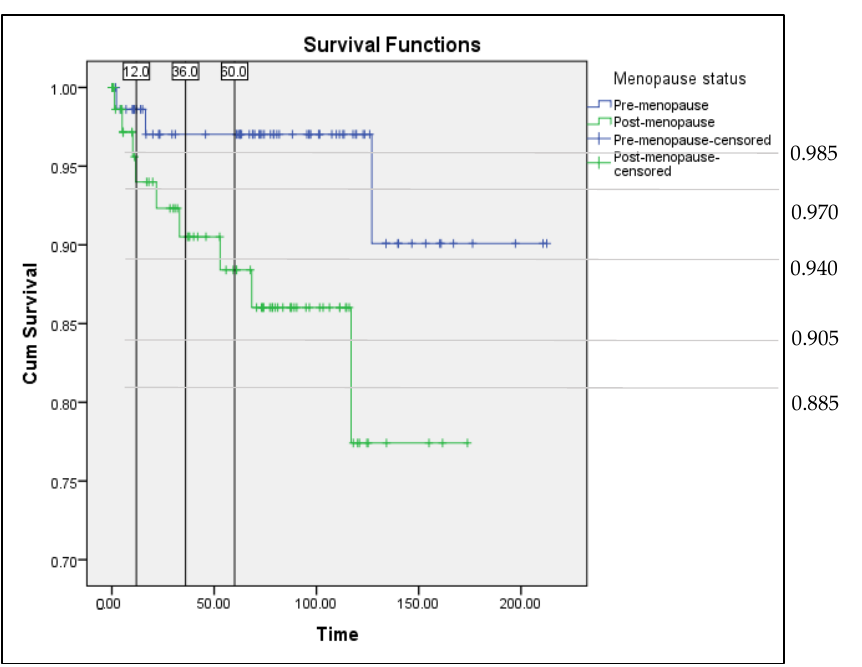
Figure 2. Survival curve (Kaplan – Meier method). Premenopausal group versus postmenopausal group. Progression-free survival among endometrial cancer patients in Hospital Melaka from 2002 – 2015.